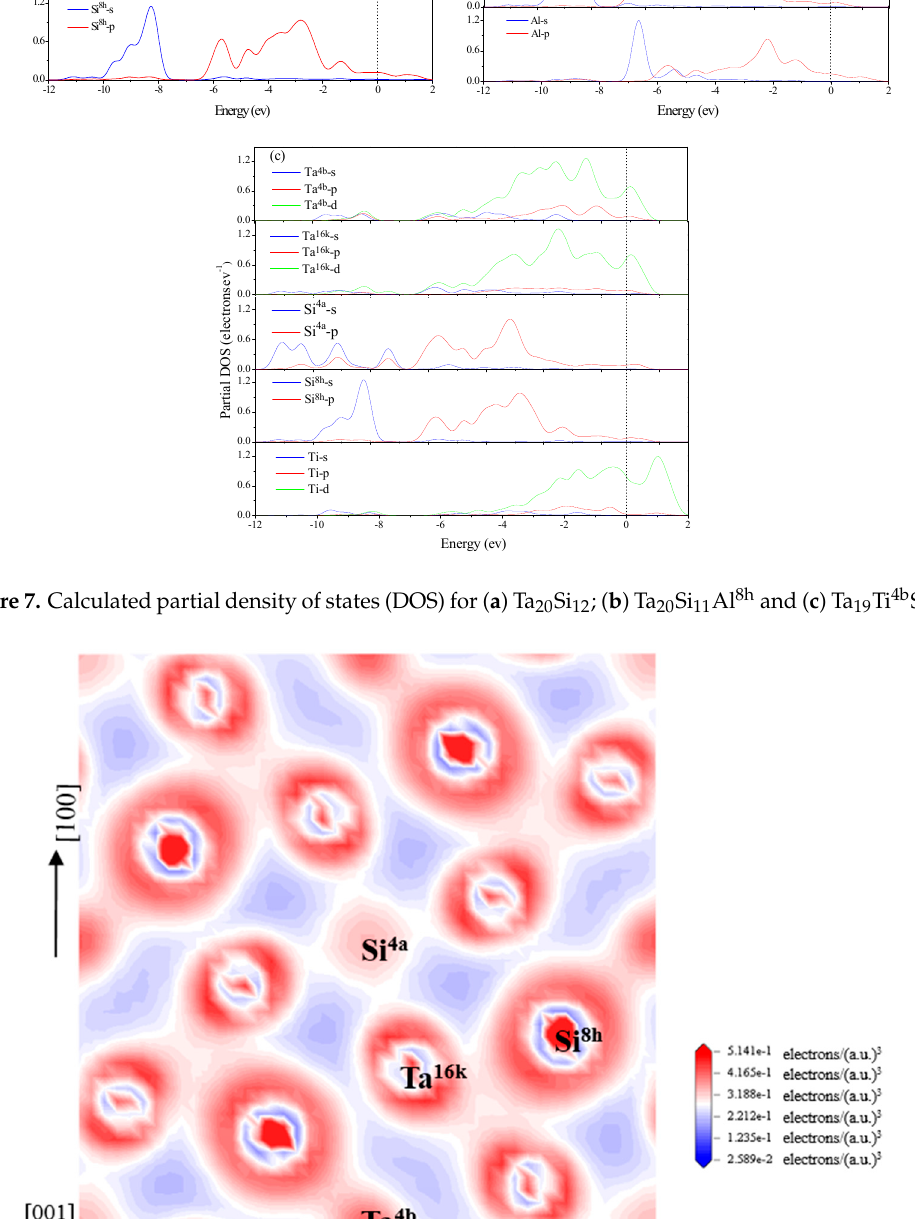
Figure 8. The difference density of contour plots for Ta 20 Si 12 unit cell in the (001) plane. ● denotes the direction perpendicular paper from inside to outside. The Ta 4b , Ta 16k , Si 4a and Si 8h symbols designate the positions of, respectively, Ta in the 4b site, Ta in the 16k site, Si in the 4a, and Si in the 8h site.